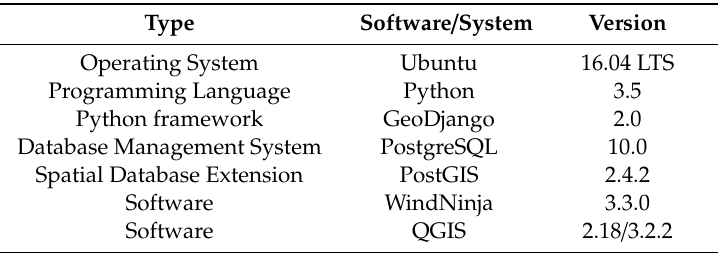
Table 1. System information of the